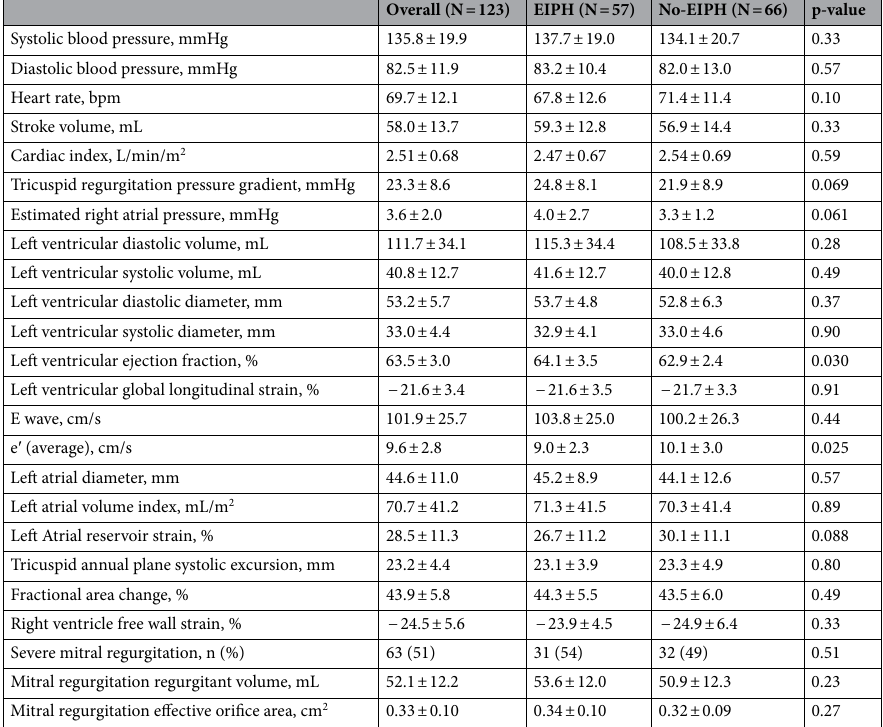
Table 3. Hemodynamics and echocardiographic data at rest. EIPH exercise-induced pulmonary hypertension.